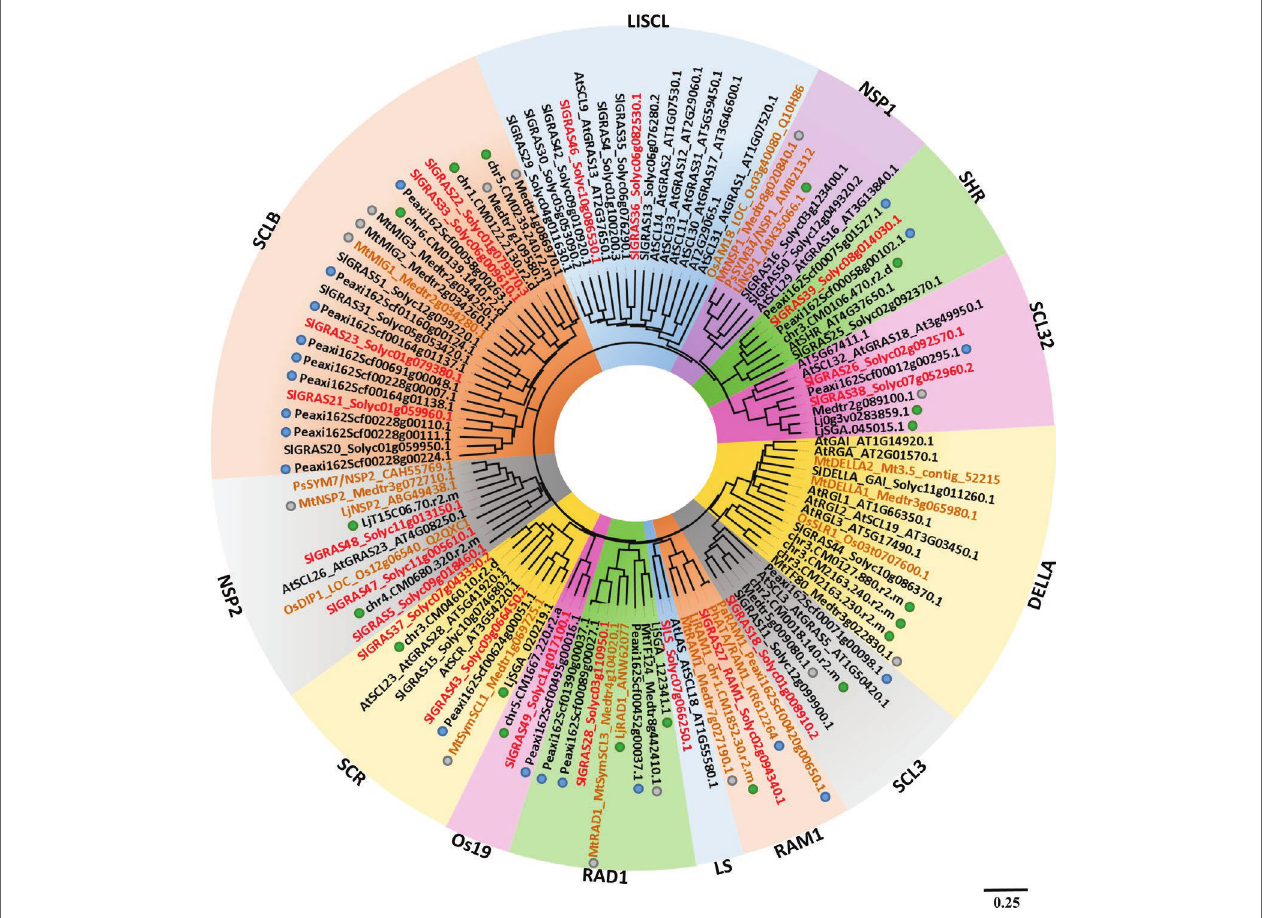
FIGURE 2 | Phylogenetic analysis of AM-related GRAS protein family members in S. lycopersicum . An unrooted phylogenetic tree was generated according to amino acid alignment of GRAS proteins from tomato and Arabidopsis (Tian et al., 2004), together with AM-induced GRAS members from P. hybrida (blue dots), L. japonicus (green dots), and M. truncatula (gray dots), as well as proteins previously reported to be involved in AM symbiosis (typed in brown) from L. japonicus (LjRAD1, LjNSP1, and LjNSP2), P. hybrida (PhATA/RAM1), M. truncatula (MtDELLA1, MtDELLA2, MtMIG1, MtRAM1, MtNSP1, and MtNSP2), Oryza sativa (OsDIP1, OsAM18), and Pisum sativum (PsSYM7, PsSYM34). Tomato GRAS proteins, whose corresponding coding genes were induced upon mycorrhization during RNA-seq analysis, are typed in red. Common protein names assigned by Huang et al. (2015) are indicated. The SolDB accessions (http://solgenomics.net/) for tomato proteins and the PlantGDB IDs (http://www.plantgdb.org) for Arabidopsis and Medicago proteins are also shown. GenBank/RefSeq accession numbers are used for proteins from other species. Background colors correspond to each clade from the GRAS protein family. The scale bar represents the number of substitutions per